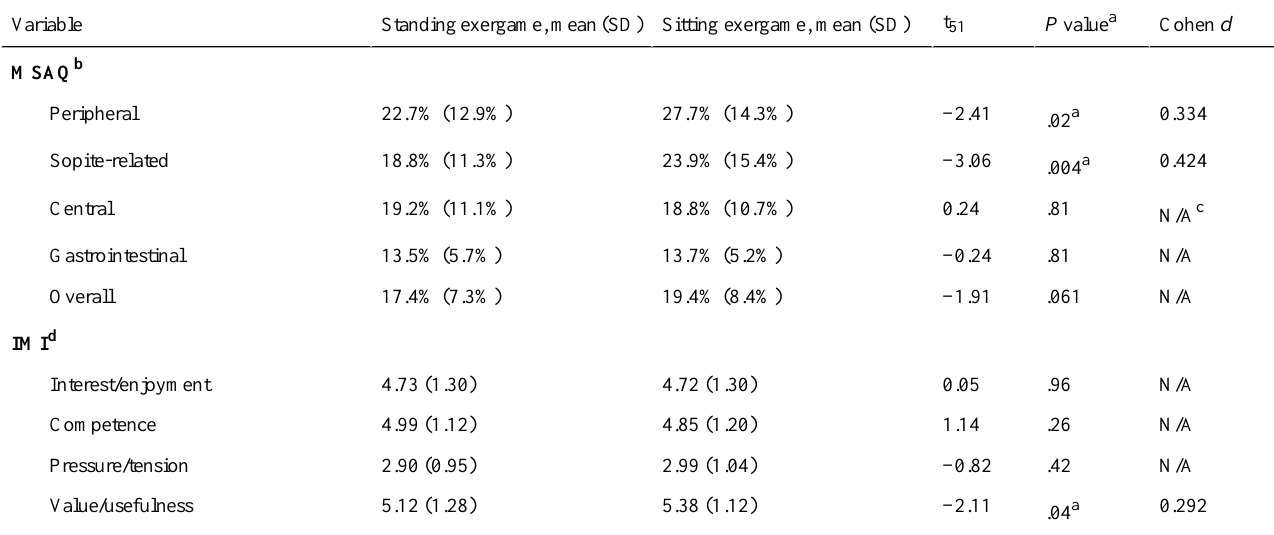
Table 4. Motion Sickness Assessment Questionnaire and Intrinsic Motivation Inventory test